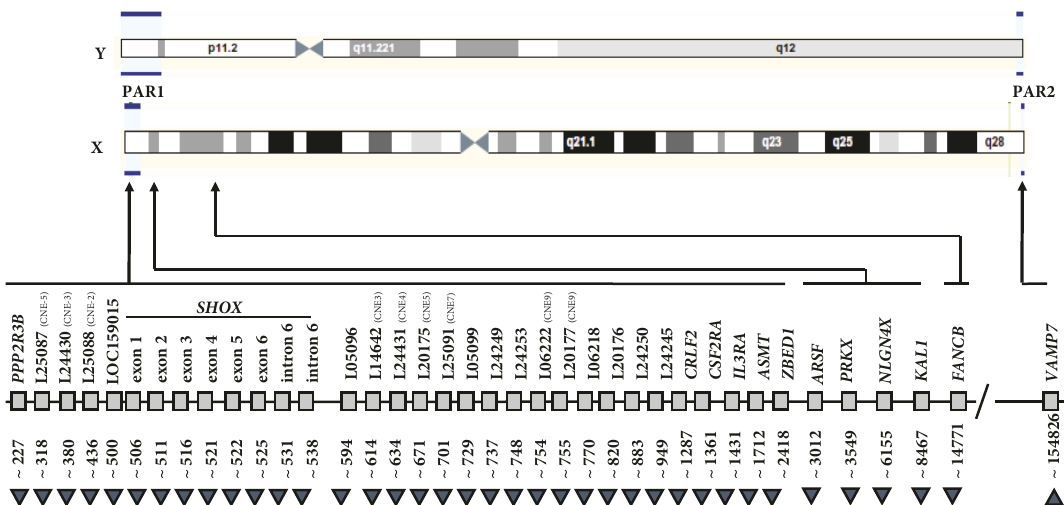
Figure 4: PARs alterations detected by MLPA. (Up) PARs are depicted with blue lines over sexual chromosome diagram; (middle) name and position (Kb from p-telomere) of each MLPA SALSA P018-G1 probe are indicated with a grey square (diagram not drawn to scale); (down) MLPA analysis result where black triangle ( 󳵳 ) reduced copy number ( < 2) and inverted black triangle ( 󳶃 ) increased copy number ( > 2) of the MLPA specific probe. CNE: conserved noncoding elements.